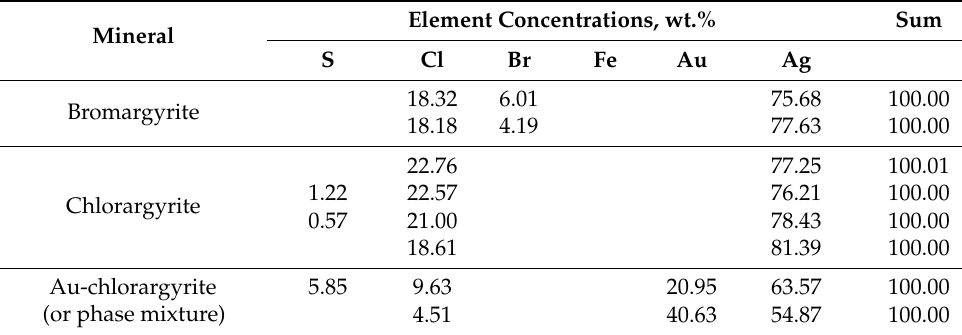
Table 5. Compositions of silver halides in the Corrida